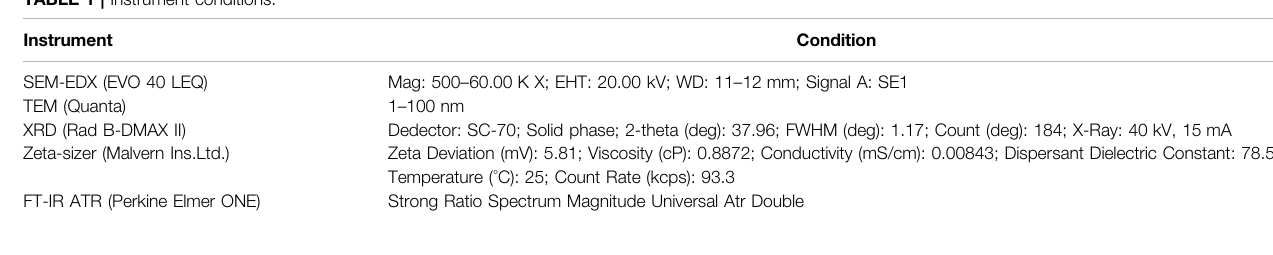
TABLE 1 | Instrument